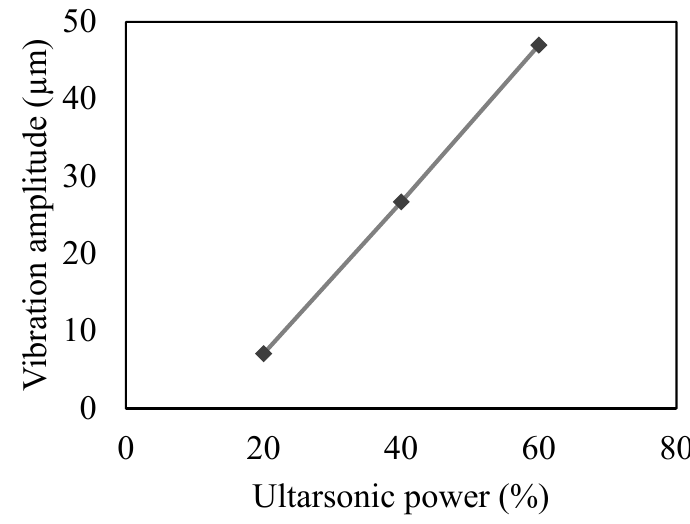
Figure 2. Relationship between ultrasonic power (%) and vibration amplitude ( µ m). Table 3. Machining parameters and their selected values.